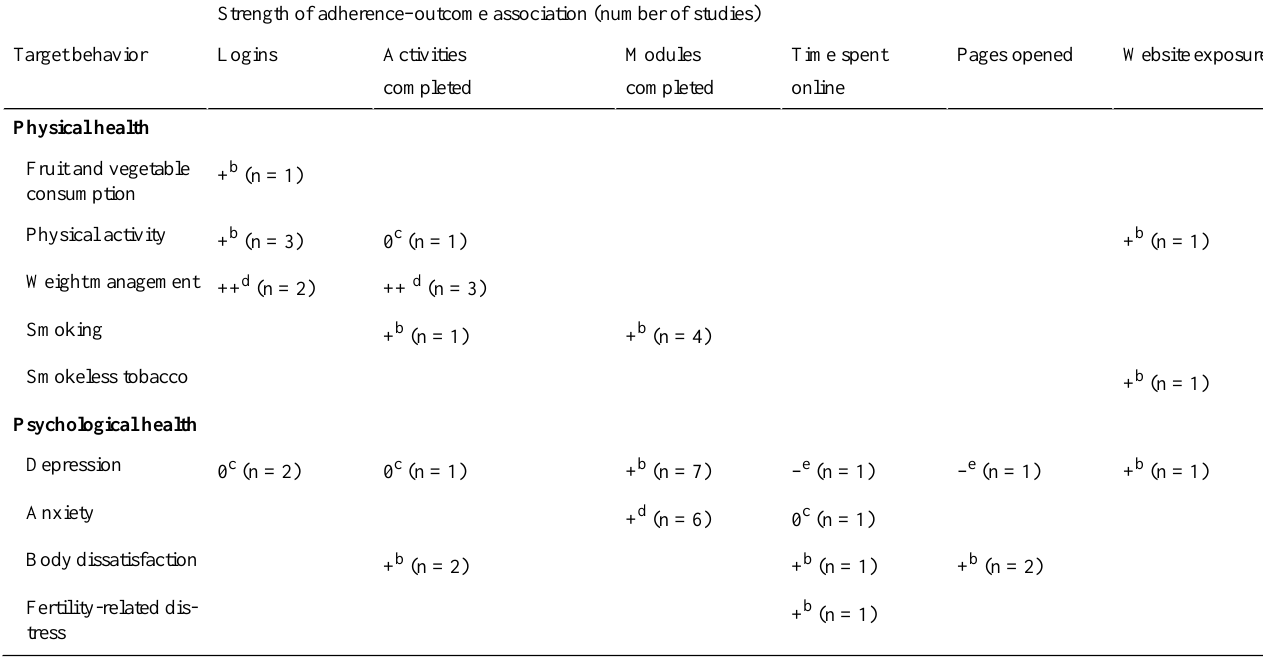
Table 3. Summary of the strength of aggregated adherence measure data by target behaviora Strength of adherence–outcome association (number of